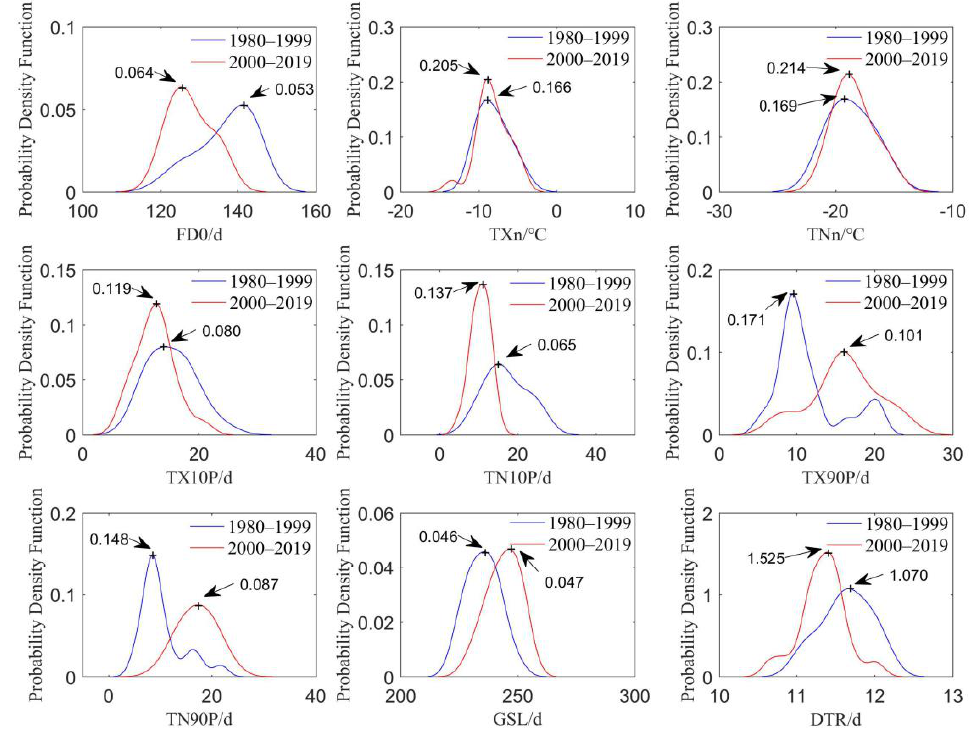
Figure 7. Probability density functions for Beijing–Tianjin–Hebei extreme temperature indices from 1980 to 2019 for two time periods: 1980 – 1999, and 2000 – 2019.